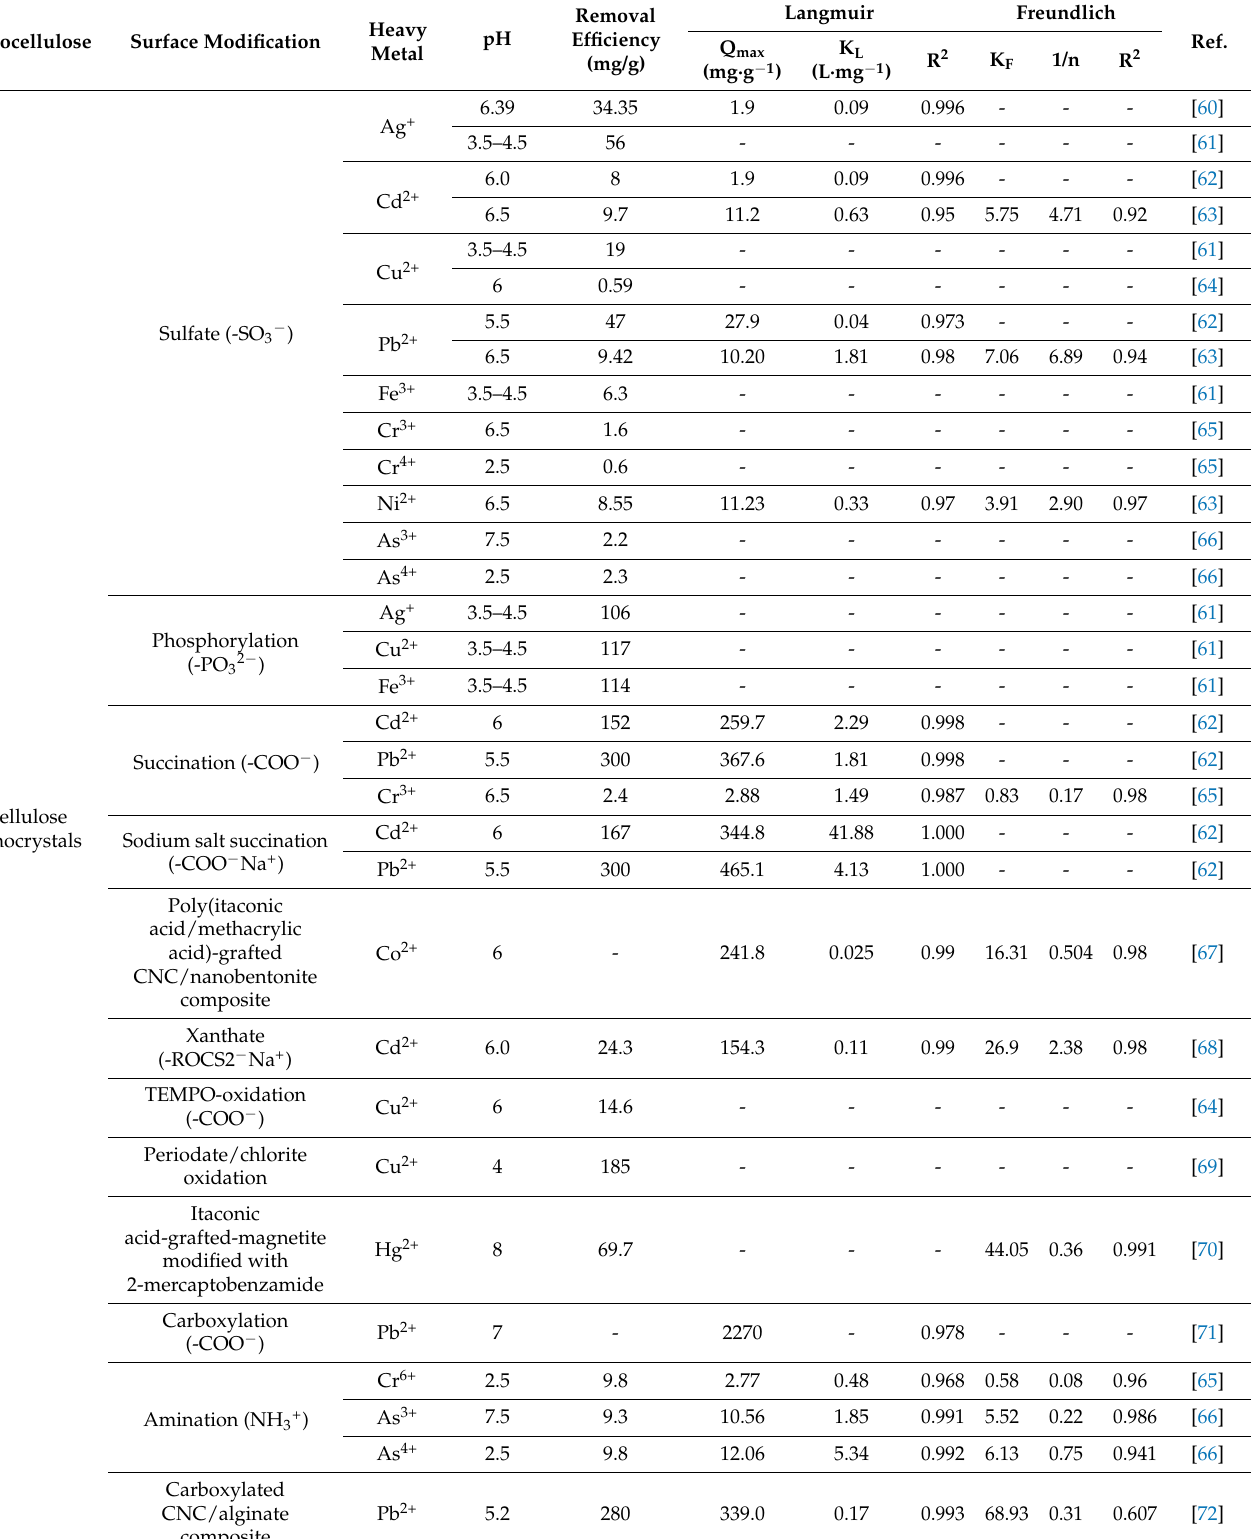
Table 3. Nanocellulose materials and their surface modifications are exploited as adsorbents for heavy metal pollutant removal from wastewater. BC—bacterial